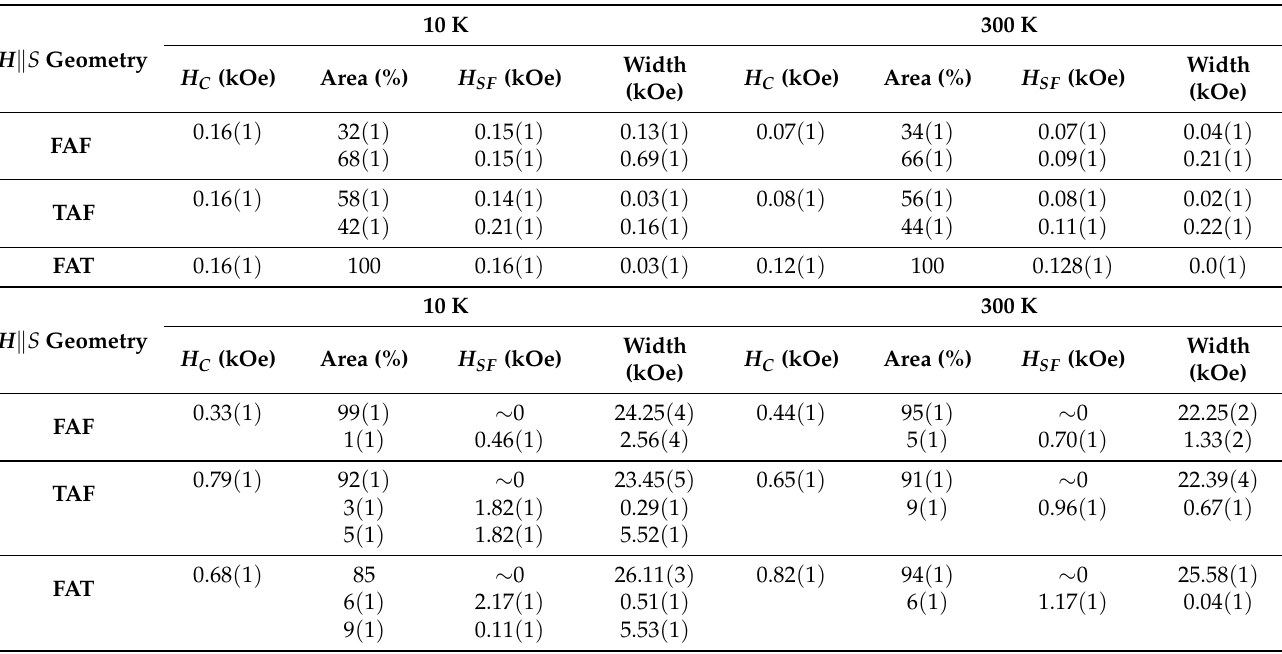
Table A1. Values of coercive field ( H C ), switching field ( H SF ) and its width and percentage area for H (cid:107) S and H ⊥ S measured at low and high